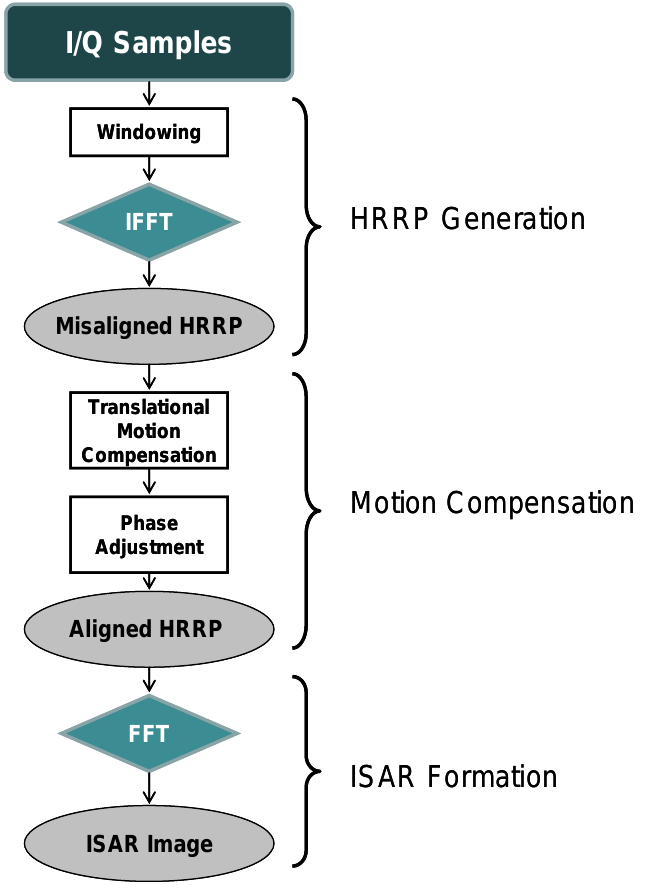
Figure 7. ISAR image formation